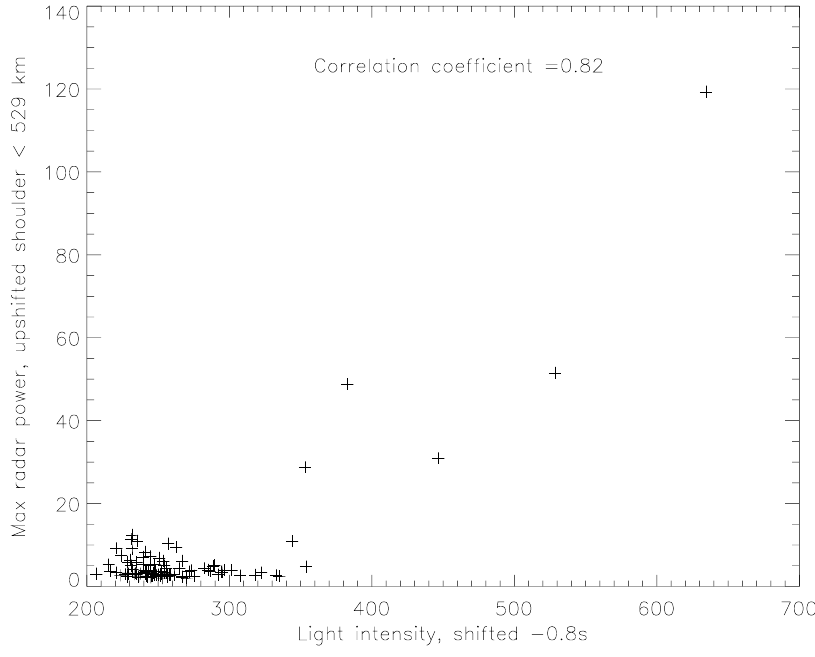
Fig. 15. Scatter plot of normalised light intensity (arbitrary units) versus maximum power (arbitrary units) in the upshifted shoulder of the received radar spectrum (taken below 529km). The light intensity stems from the time series taken from region b1 in Fig. 5, delayed by 0 .